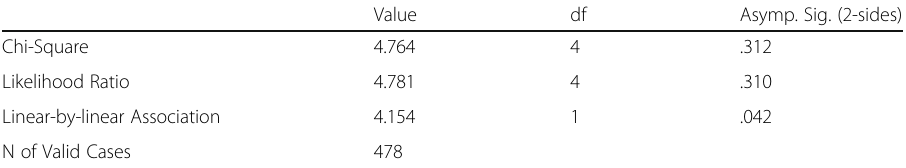
Table 5 Results of Chi-Square Tests for Different Tokens of EWs Used in English and Persian Short Stories Value df Asymp. Sig. (2-sides) Chi-Square 4.764 4 .312 Likelihood Ratio 4.781 .310 Linear-by-linear Association .042 N of Valid Cases